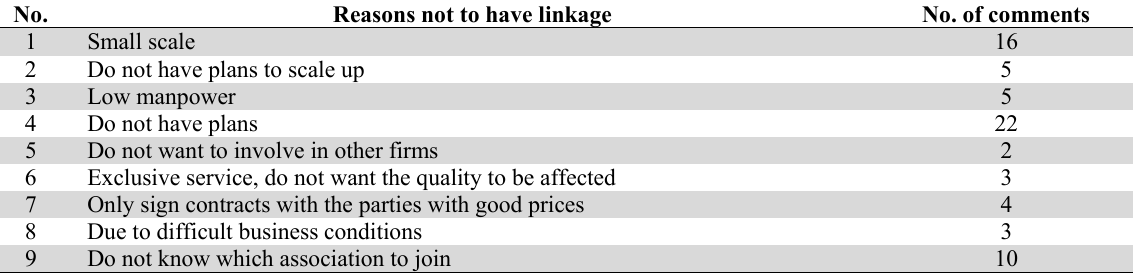
Causes of not Linking Business Units of Tourism